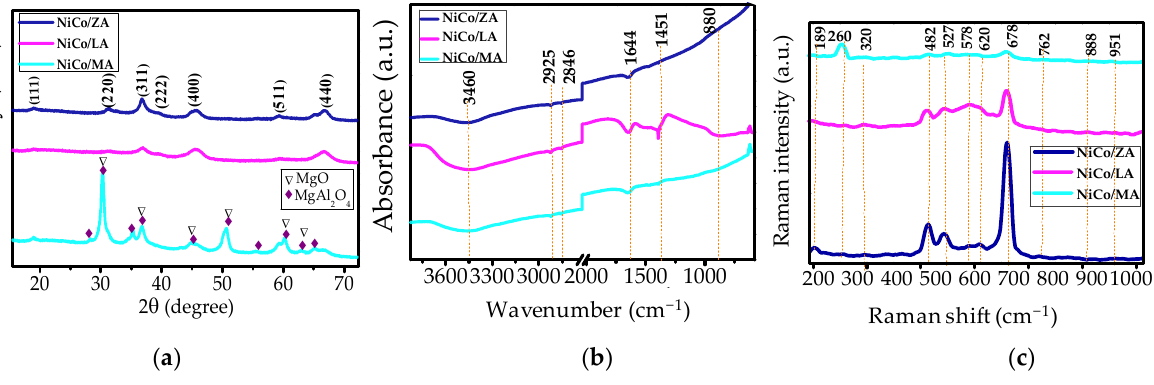
Figure 3. Physicochemical characterizations of the supported samples: ( a ) XRD, ( b ) FTIR and ( c ) Raman measurements. The letters NiCo/LA, NiCo/ZA and NiCo/MA represent the NiCo/La 2 O 3 – Al 2 O 3 , NiCo/ZnO–Al 2 O 3 and NiCo/MgO–Al 2 O 3 supported catalysts, respectively.